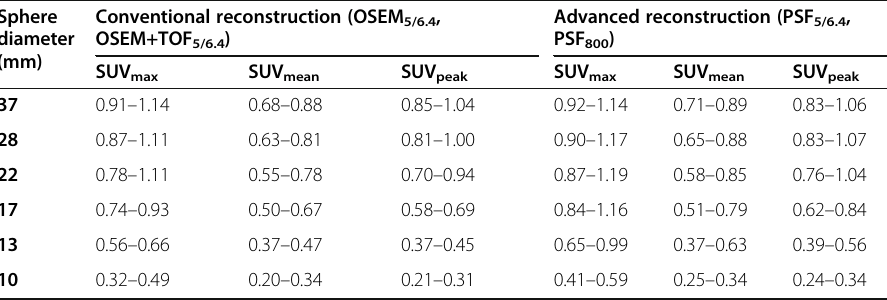
Table 2 Proposed specification limits for Gallium-68 multi-centre trials Sphere diameter